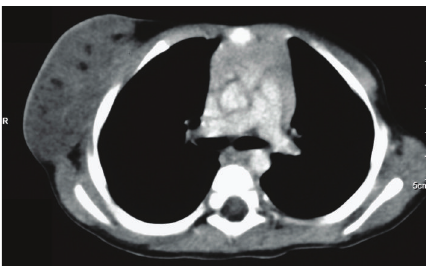
Figure 9: CT of the chest showing an 8cm × 7cm × 3 cm enhancing mixed density mass in the right chest